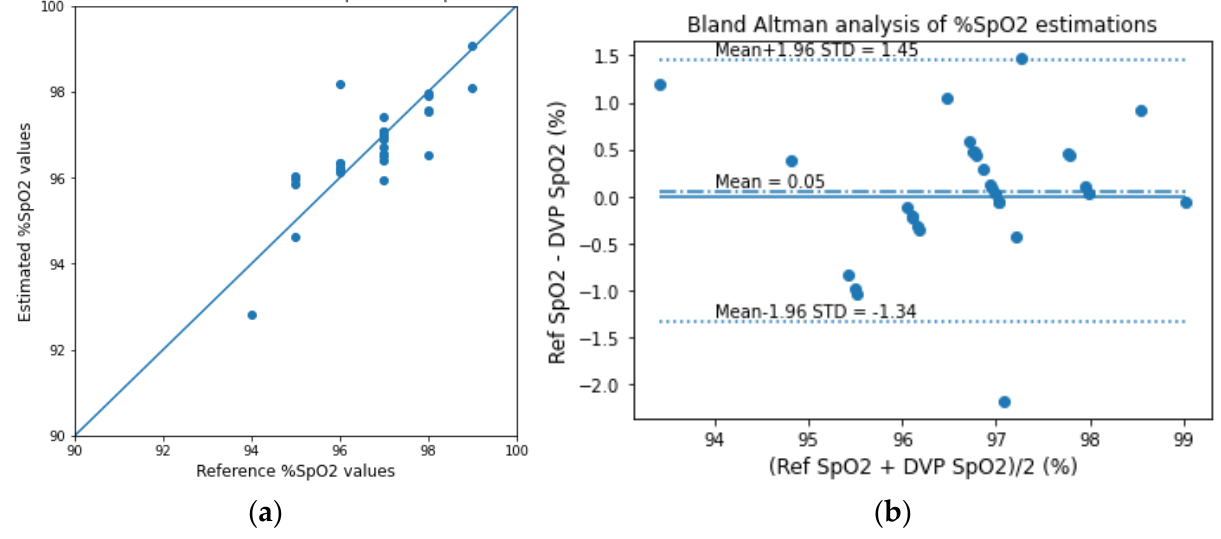
for the reflection-type signal of the fingertip model. the reflection-type signal of the fingertip model.